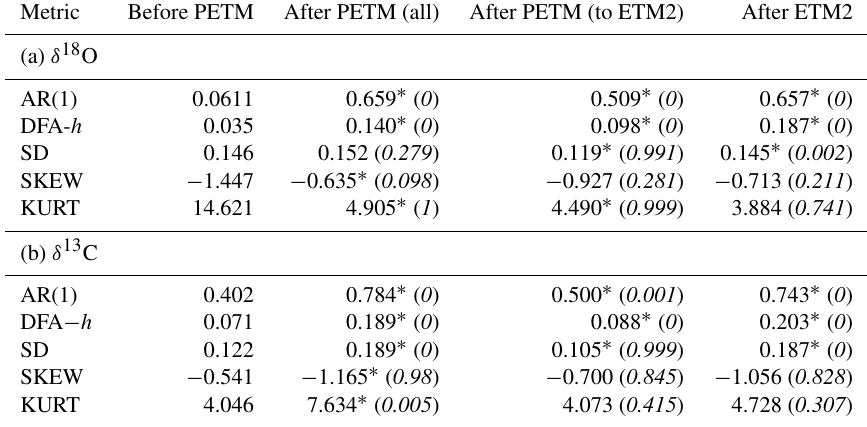
Table 1. Values of binned metrics for both benthic δ 18 O (a) and δ 13 C (b) . Bins are of all data (detrended but not interpolated) before the PETM, all data after the PETM (including data from within ETM2), all data between the PETM and ETM2, and all data after ETM2. The indicators are AR(1) coefficient, detrended fluctuation analysis h value (DFA- h ), standard deviation (SD), skewness (SKEW), and kurtosis (KURT). Each value is followed by a p value (in italics within parentheses and preceded by a ∗ if significant) computed using a permutation test, except for AR(1) and DFA- h for which we instead use AR(1) model-derived surrogate data to compare against (see Methods for details). Metric Before PETM After PETM (all) After PETM (to ETM2) After ETM2 (a) δ 18 O AR(1) 0.0611 0.659 ∗ ( 0 ) 0.509 ∗ ( 0 ) 0.657 ∗ ( 0 ) DFA- h 0.035 0.140 ∗ ( 0 )